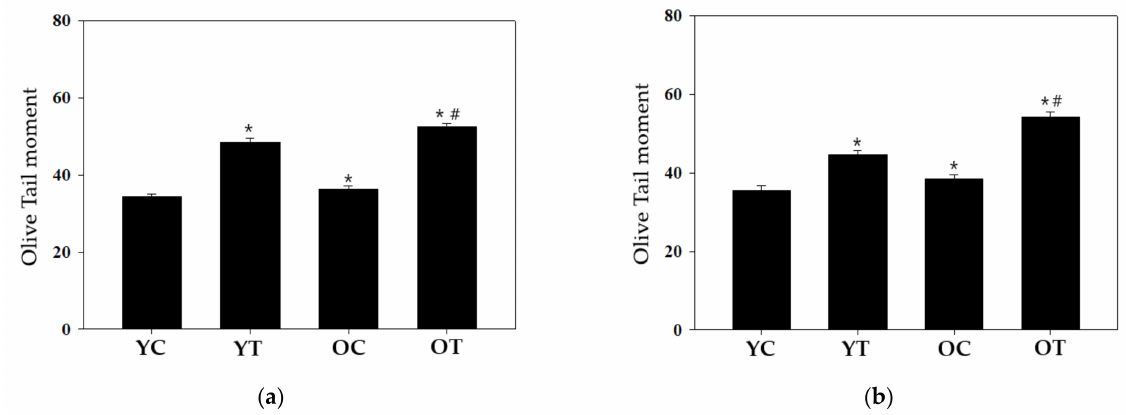
Figure 4. Quantitative analysis of C57BL/6 lung-cell DNA damage after DEP exposure using single-cell gel electrophoresis (comet assay). ( a ) Male mice; ( b ) Female mice. YC: young mice (8-week-old) control, YT: 50 µ g DEP- instilled young mice (8-week-old), OC: old mice (40-week-old) control, OT: 50 µ g DEP- instilled old mice (40-week-old). * p < 0.05 when compared with the young mice control. # p < 0.05 when compared with the old mice control.